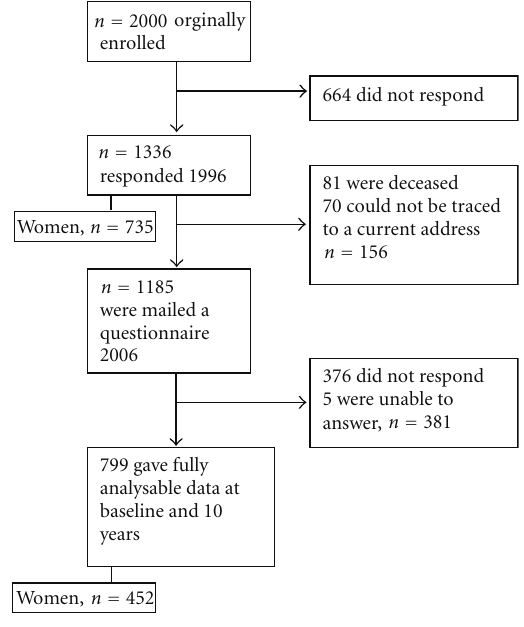
Figure 2: Flow of study participants.